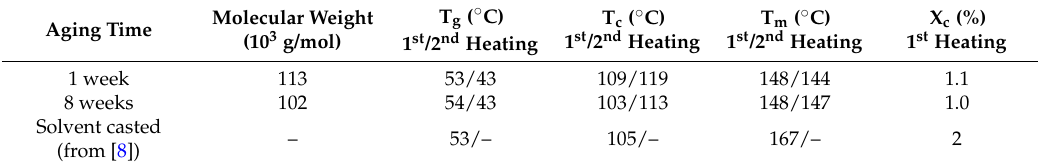
Figure 2. DSC curves (1st and 2nd heating) of PLA/MMT films after one and eight weeks of latex ageing. The curves were displaced vertically for easier reading. Table 1. Thermal properties of polylactides (PLA)/montmorillonite (MMT) latexes after 1 and 8 weeks of